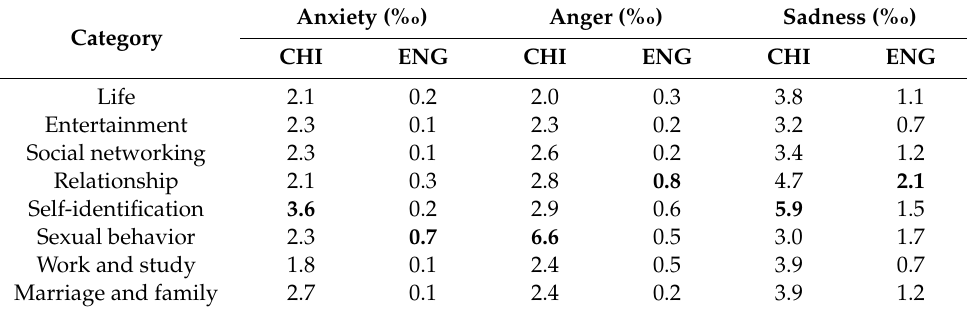
Table 5. Scores of negative emotions of each category calculated by the LIWC programs.